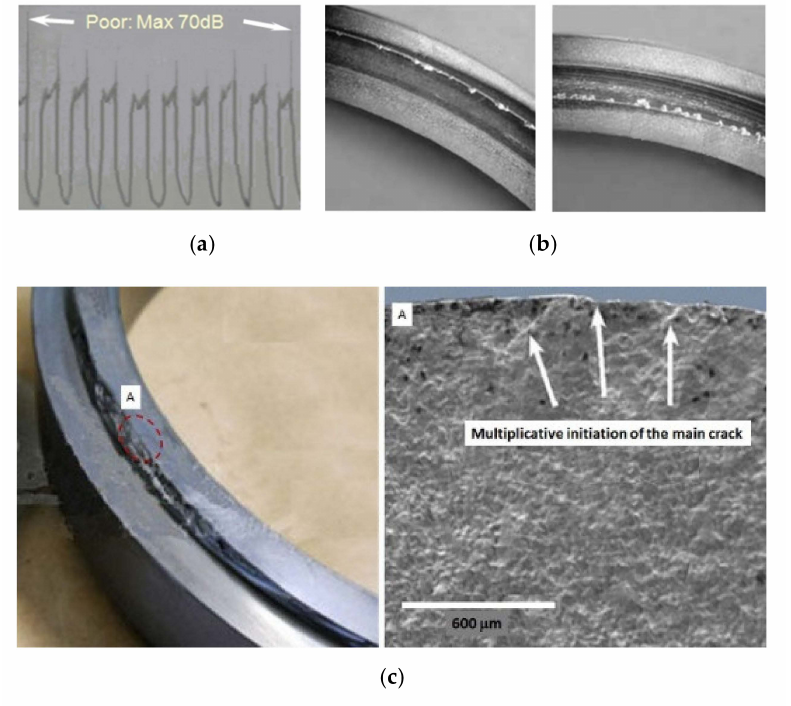
Figure 11. Design issues of pneumatic cylinder in first ALT; ( a ) sample noise, ( b ) two chipped samples, ( c ) partially cracked sample.